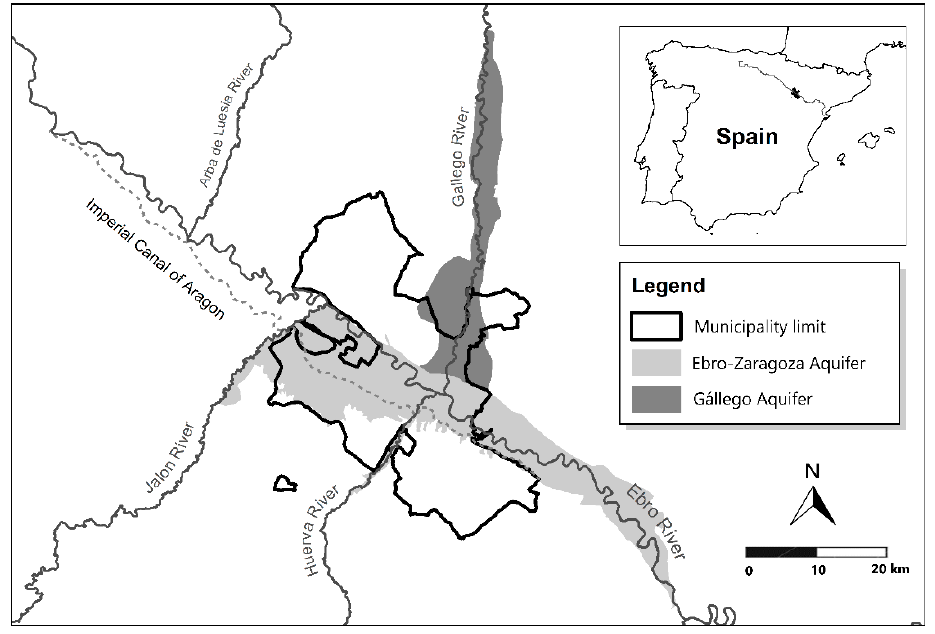
Figure 1. Location of the Ebro-Zaragoza and Gállego alluvial aquifers. Source: By the authors, based on [27,28].